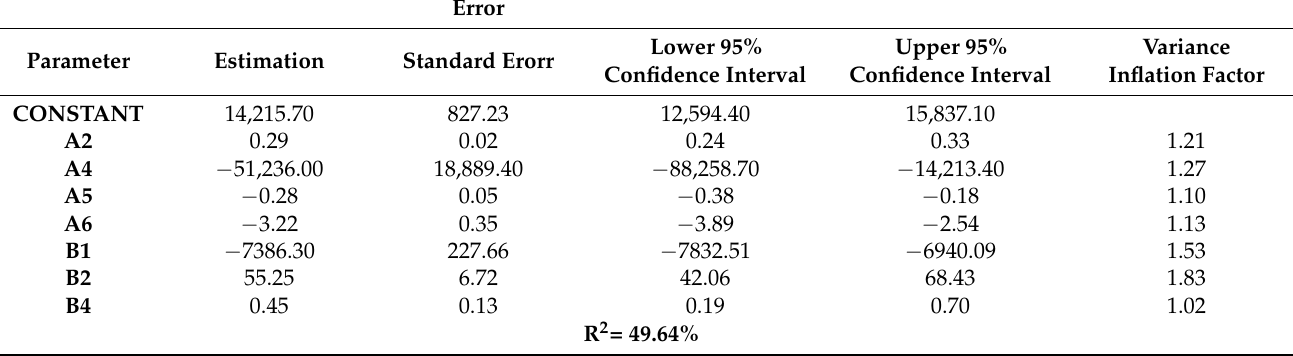
Table 2. Estimated regression model